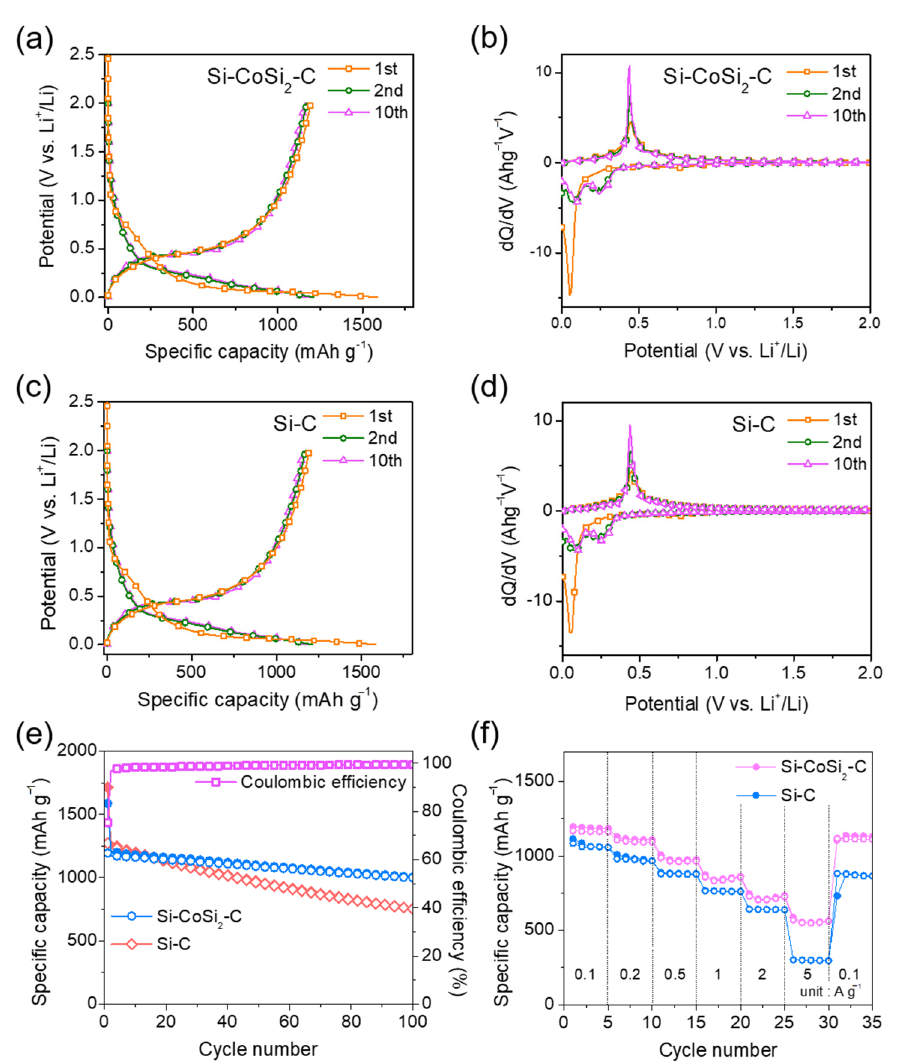
Figure 5. ( a ) Voltage profiles and ( b ) DCPs of the porous Si-CoSi 2 -C composite electrode; ( c ) voltage profiles and ( d ) DCPs of the Si-C composite electrode; ( e ) cycle performance and ( f ) rate perfor- mance of both porous Si-CoSi 2 -C and Si-C composite